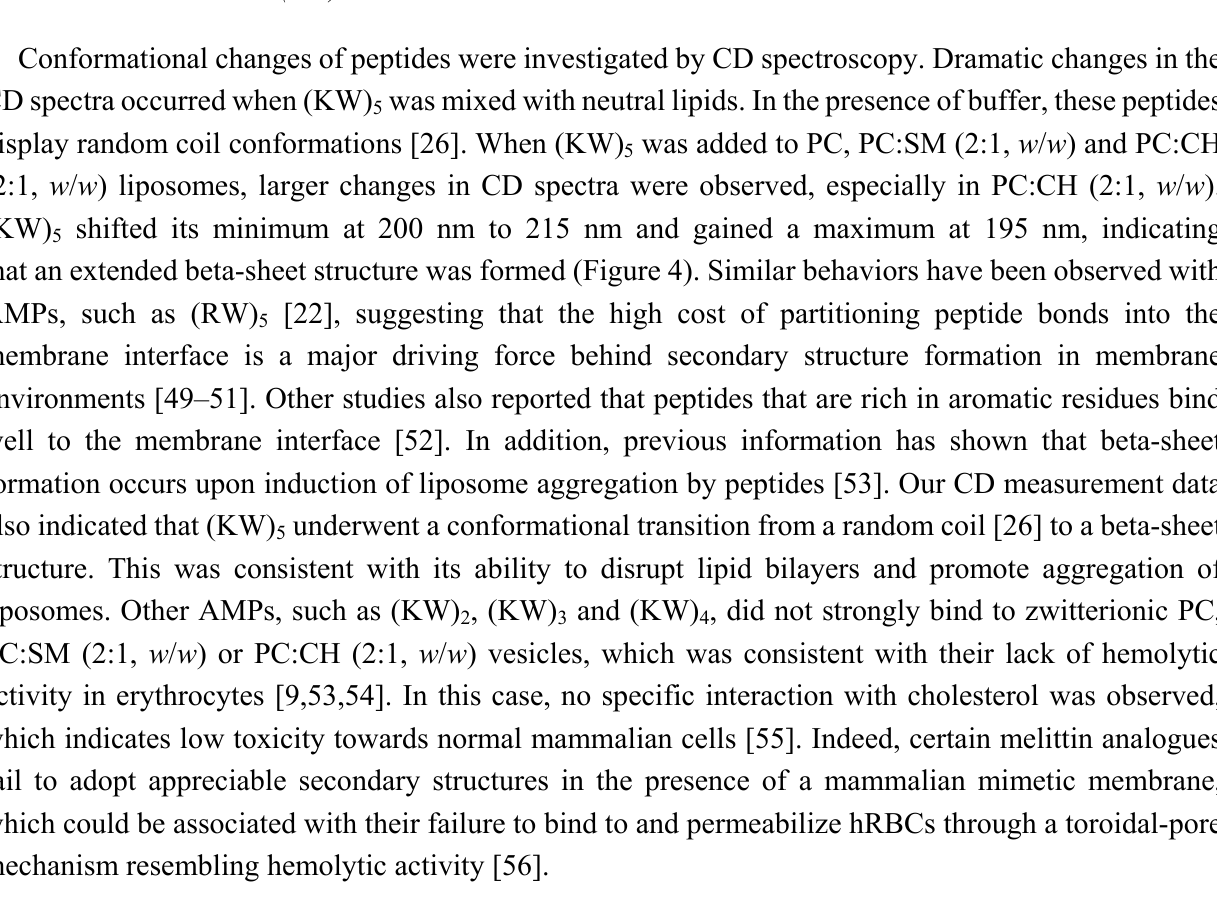
Figure 4. CD spectra for (KW)